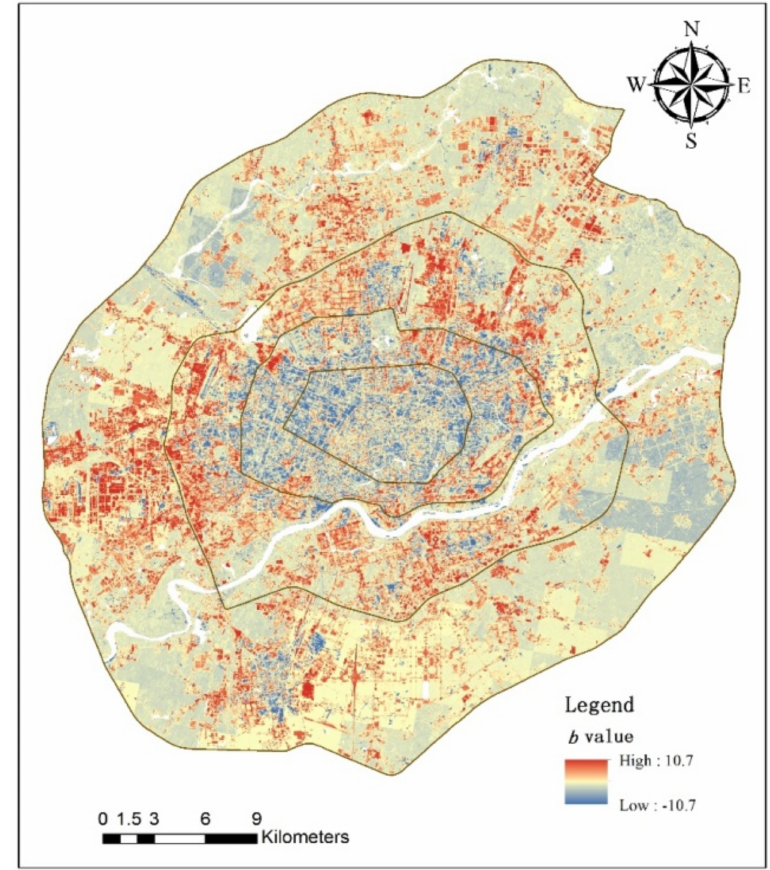
Figure 4. b -Value of direct runoff at pixel scale.